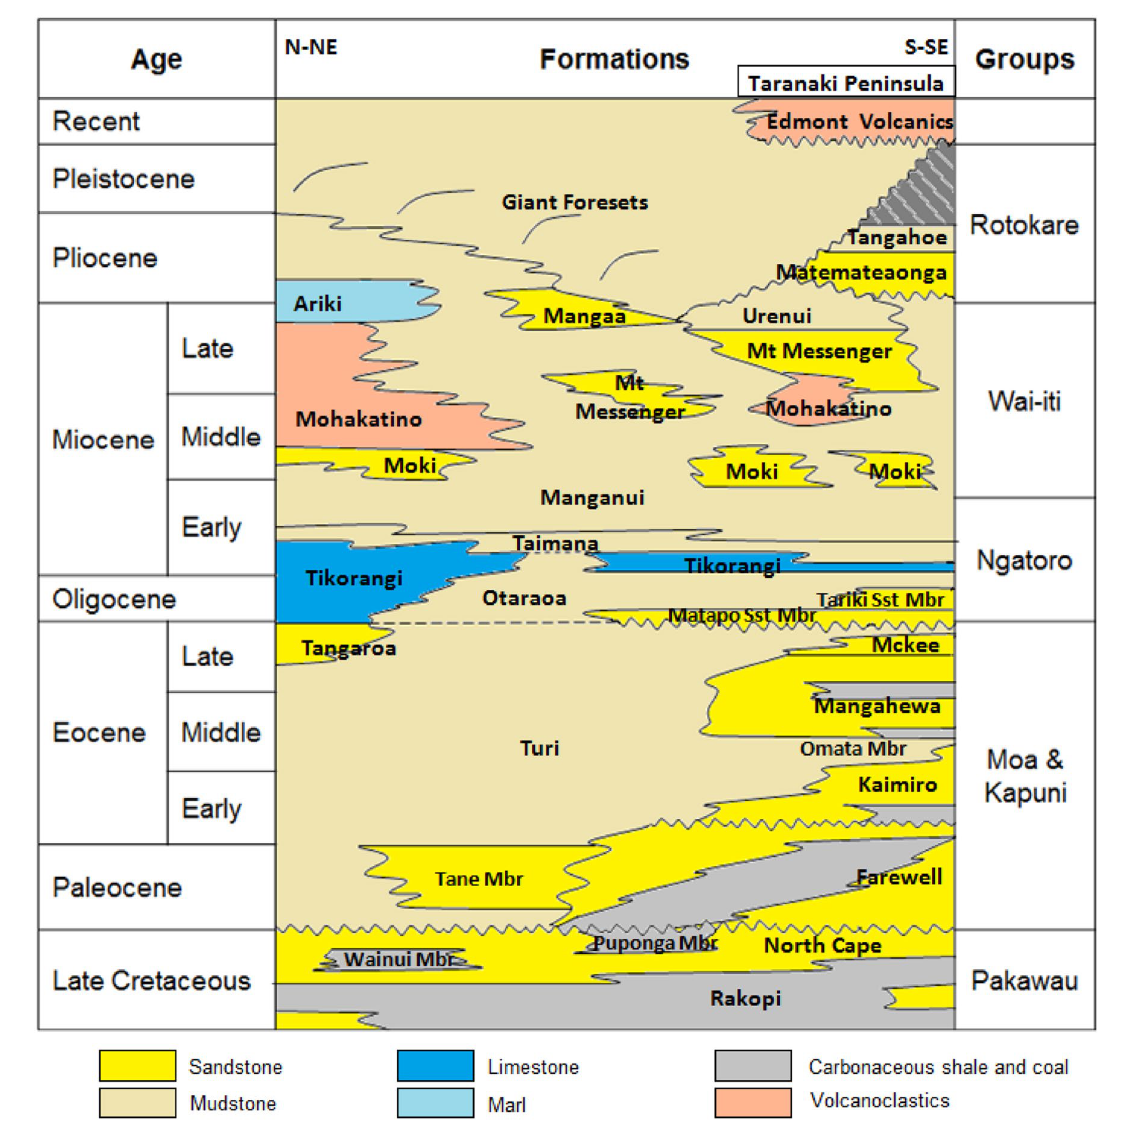
Fig. 4 Generalized chrono-stratigraphy of Taranaki Basin, modified after King and Thrasher